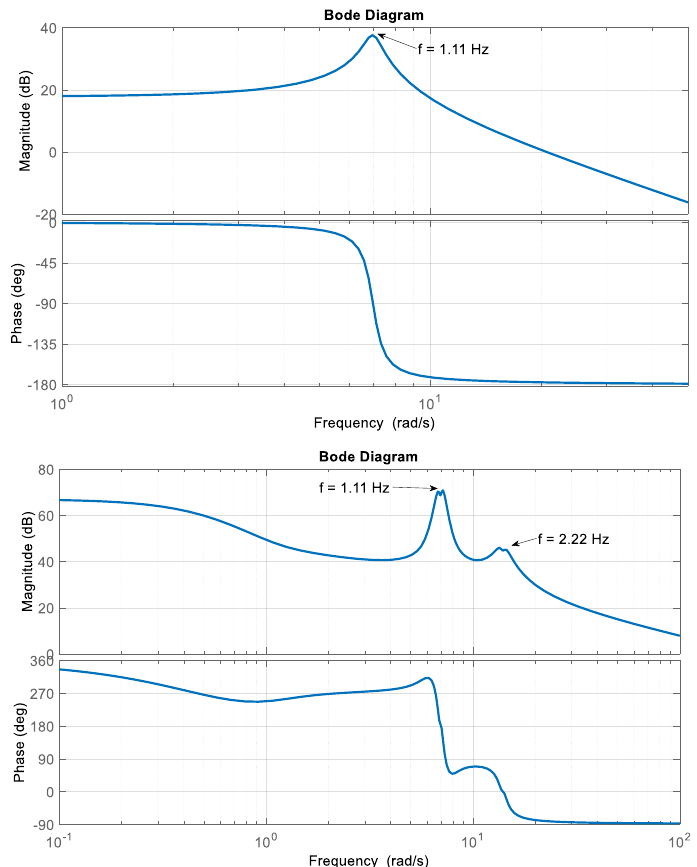
Figure 4. Bode plots of the linear and nonlinear transfer functions of the study case of synchronous machine-infinite busbar.